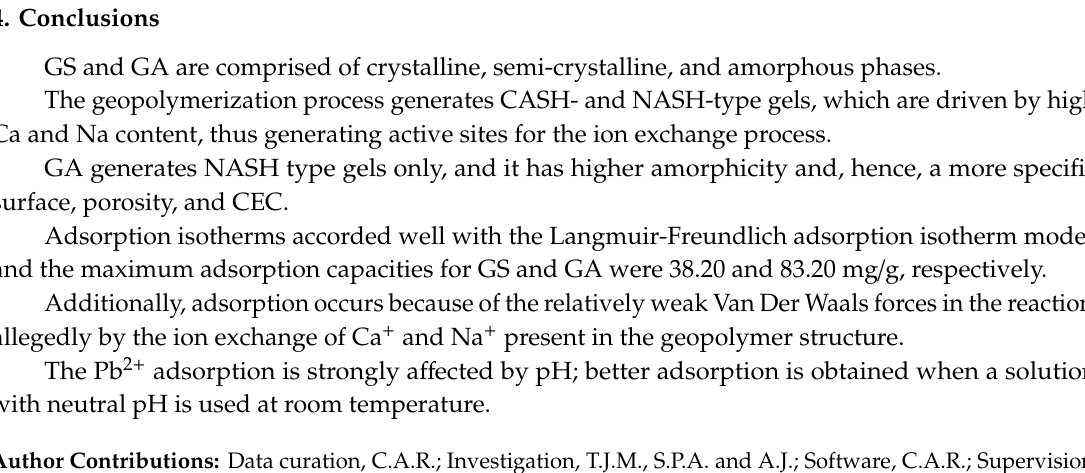
Figure 12. Langmuir–Freundlich Adsorption isotherm of GA: m = 0.15 g, V = 40 mL, pH = 4.